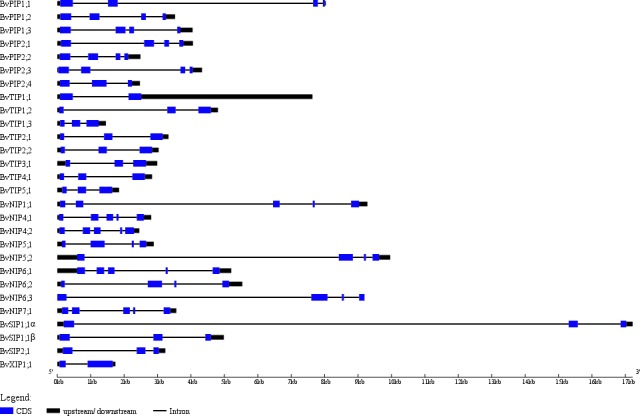
BvAQP genes structure analysis.